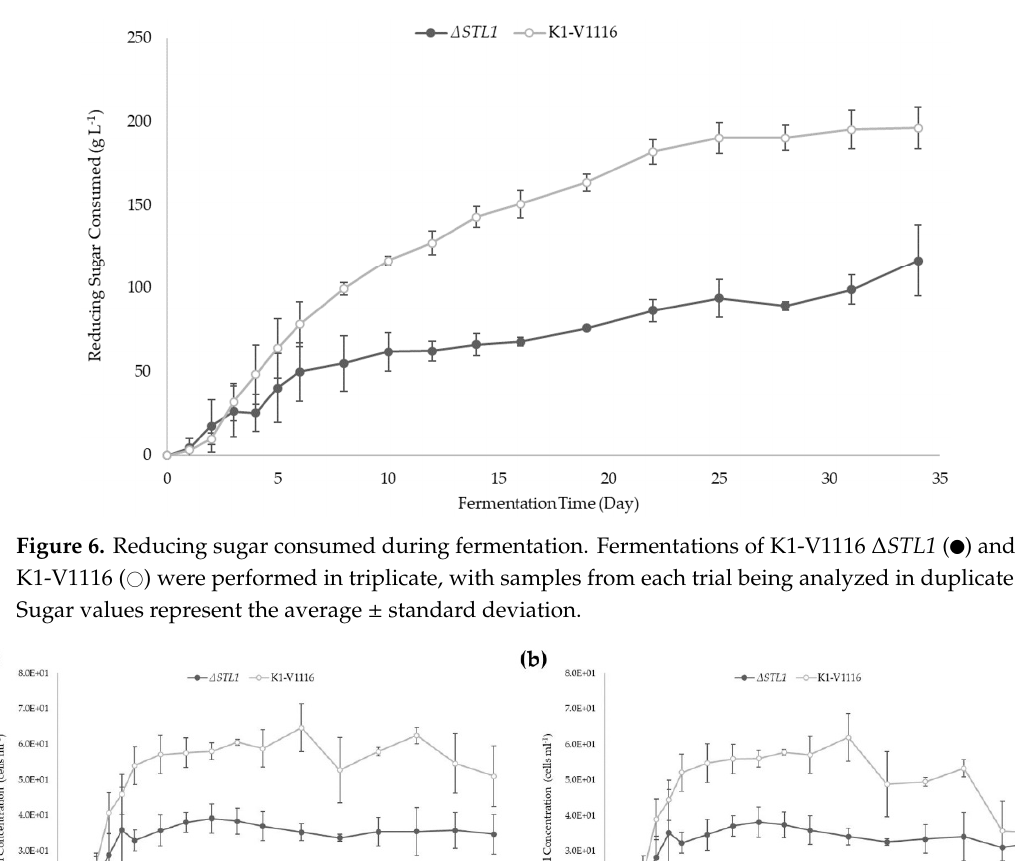
Figure 7. Fermentation total cell concentration ( a ) and viable cell concentration ( b ) of K1-V1116 ∆ STL1 ( ● ) and K1-V1116 ( ○ ). Fermentations were performed in triplicate, with counts being determined in duplicate. Cell concentrations represent the average ± standard deviation.